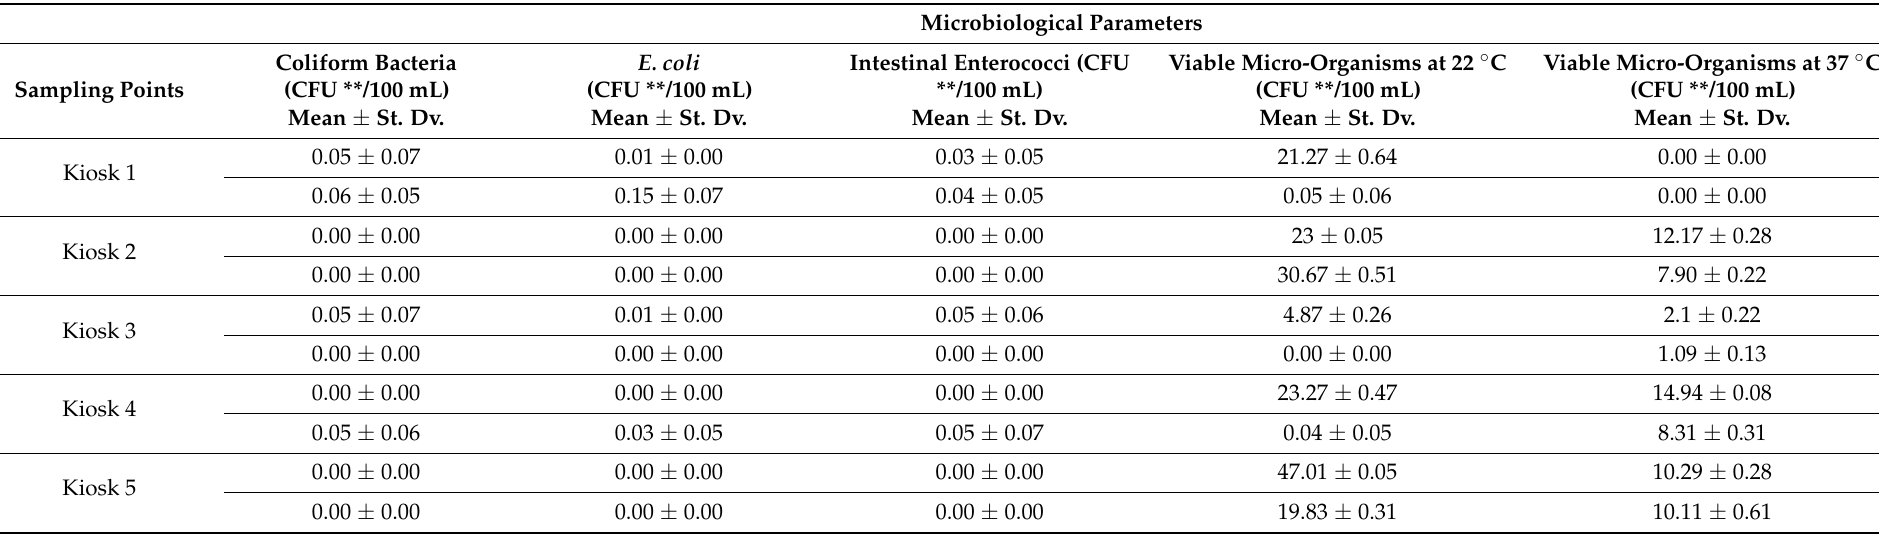
Table 2. Results of the average calculation for each microbiological parameter on the 40 water samples * from the sampling point monitoring in Case Study 1. Limits and methods of analysis specified by Lgs.D. 31/01 [18] on the quality of water intended for human consumption. * The samples were collected in two seasonal sampling campaigns carried out in April and October on all points of the monitoring network. ** CFU: colony-forming